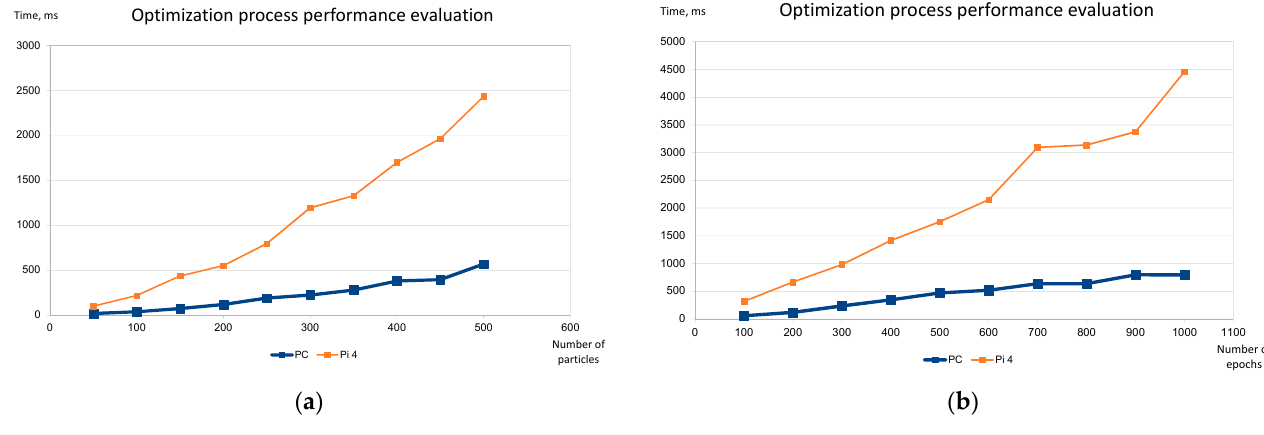
Figure 12 . Evaluation of the service placement optimization process: ( a ) Time dependency on the number of particles (200 epochs used); ( b ) Time dependency on the number of epochs (200 initial particles used).